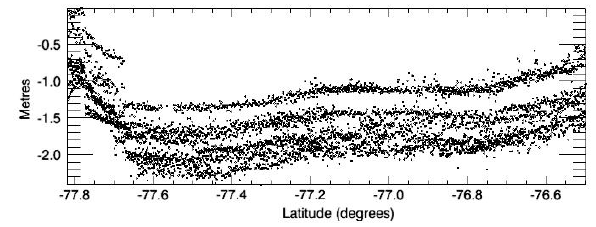
Figure 3. Repeat track of ICESat track 381 across McMurdo Sound. 9 tracks are present in the repeat with 5 covering the full length of the study area. All five tracks exhibit an unexpected positive deviation in h at the northern end of the profile.